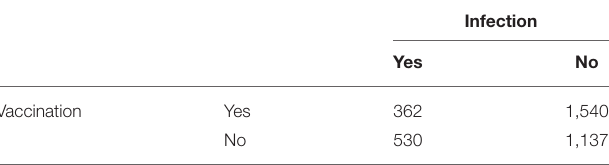
TABLE 5 | A summary of all studies included in the meta-analysis.